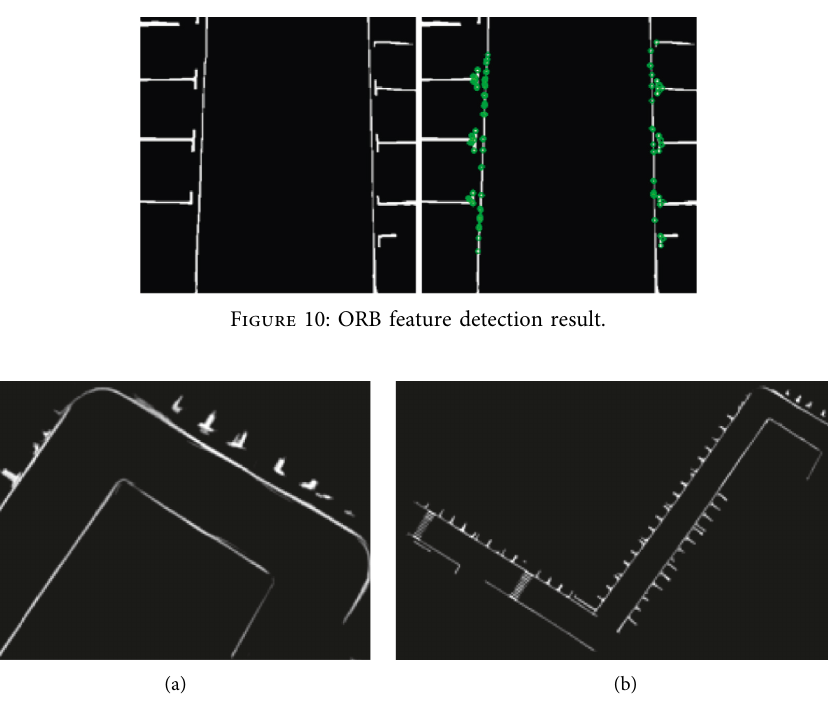
Figure 11: (a) Area map with the highest ORB matching scores. (b) Local map made by ICP method.